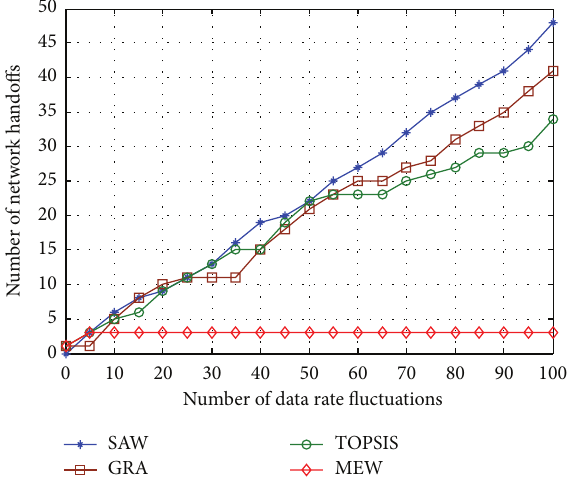
Figure 9: Network handoffs in case of weight 4. Table 10: Comparison of computational